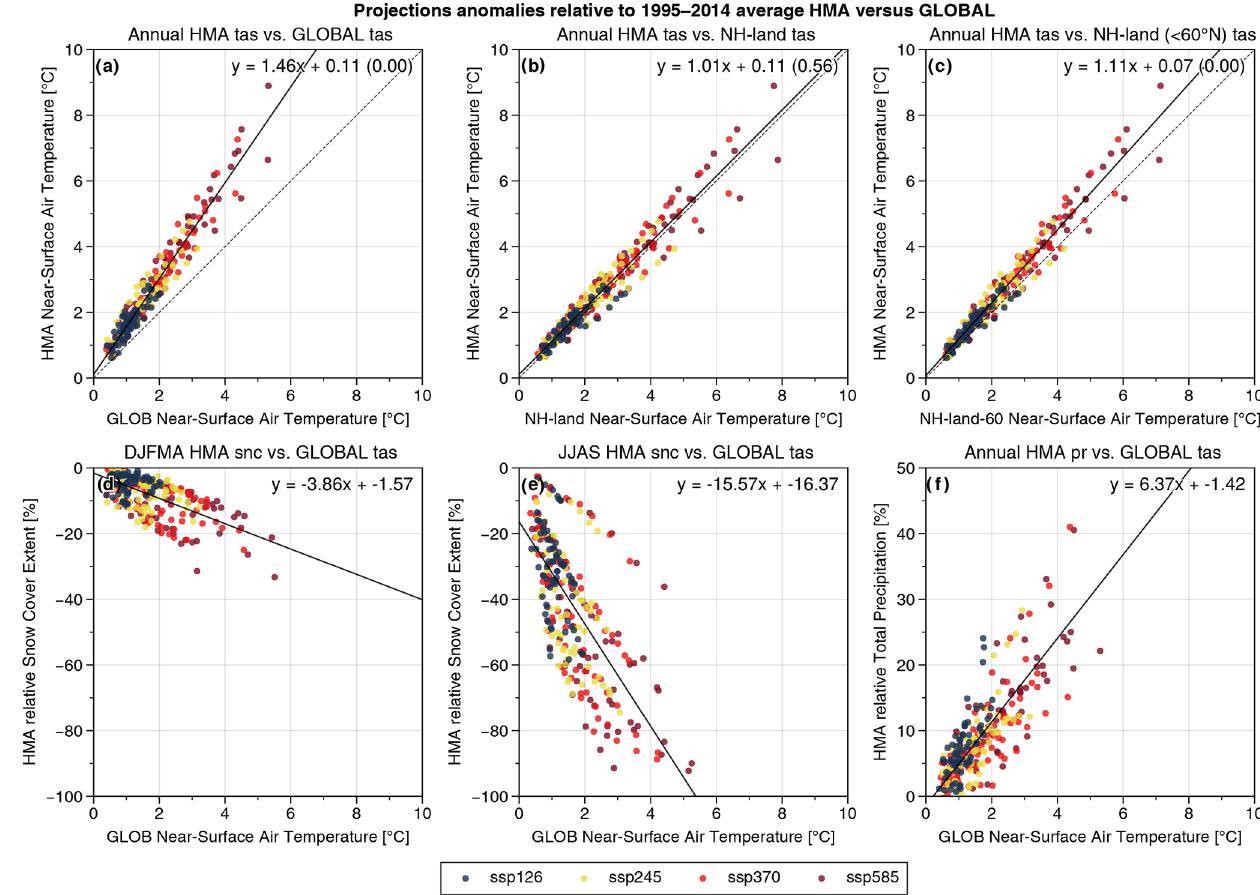
Figure 11. Projected anomalies over HMA computed with respect to 1995–2014 averages for the 10 models under the SSP1-2.6 (dark blue), SSP2-4.5 (yellow), SSP3-7.0 (red) and SSP5-8.5 (dark red) scenarios for annual temperature (a, b, c) , seasonal snow cover (d, e) and annual precipitation (f) as a function of temperature integrated globally (a, d, e, f) and over NH continental surfaces including (b) and excluding (c) boreal areas (latitude > 60 ◦ N). Each point on the scatter plots corresponds to a 20-year average computed with 10-year steps from 2015 to 2095. The Global Land Data Assimilation System (GLDAS) Land/Sea Mask Dataset at 1 ◦ resolution (https://ldas.gsfc.nasa.gov/gldas/ vegetation-class-mask, last access: 6 October 2020) is used to mask the continental data in the different models. The dashed line corresponds to the line of equation y = x and the solid black line to a linear regression detailed at the top right of each panel. In the first row (a–c) , a significance Wald test is done to test if the observed trend is significantly different from the equation y = x ( p value is shown in